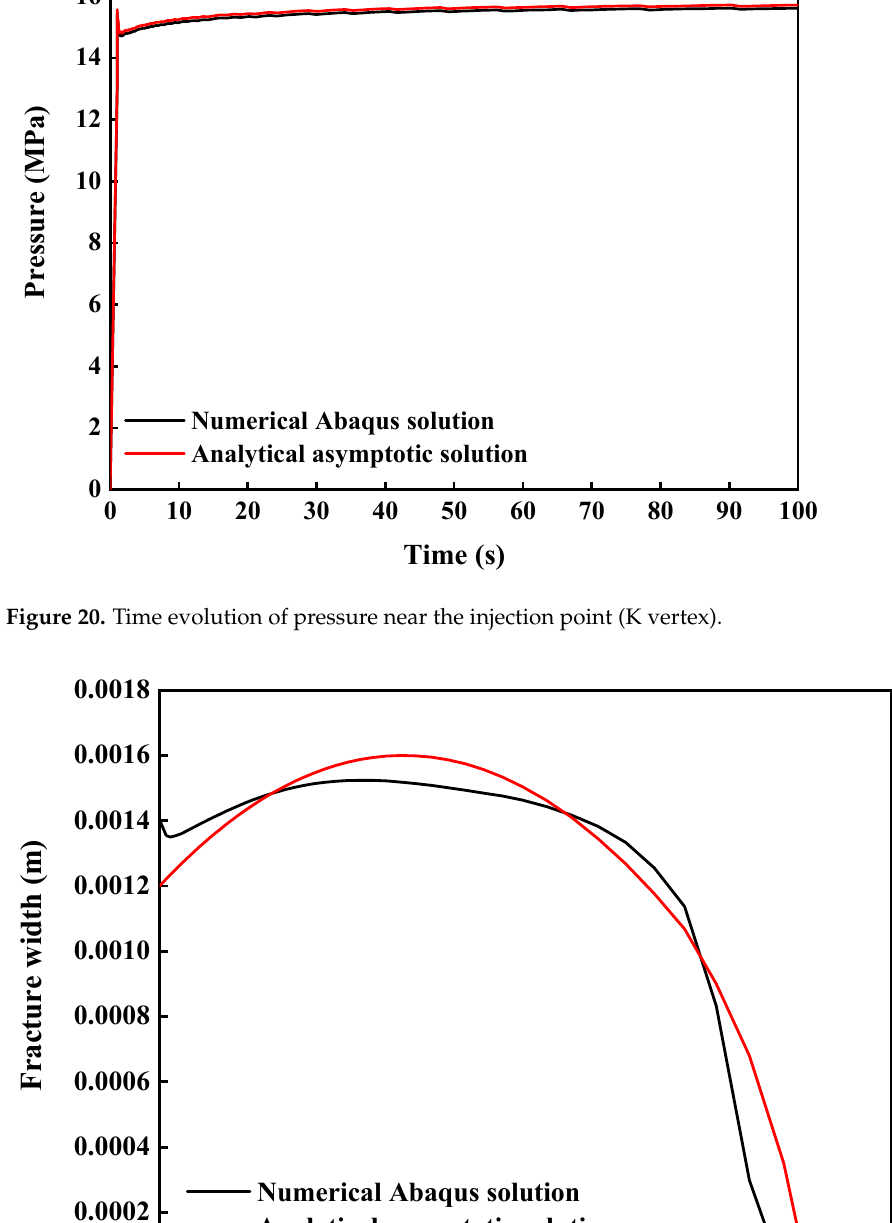
Figure 19. Time evolution of fracture length near the injection point (K vertex).